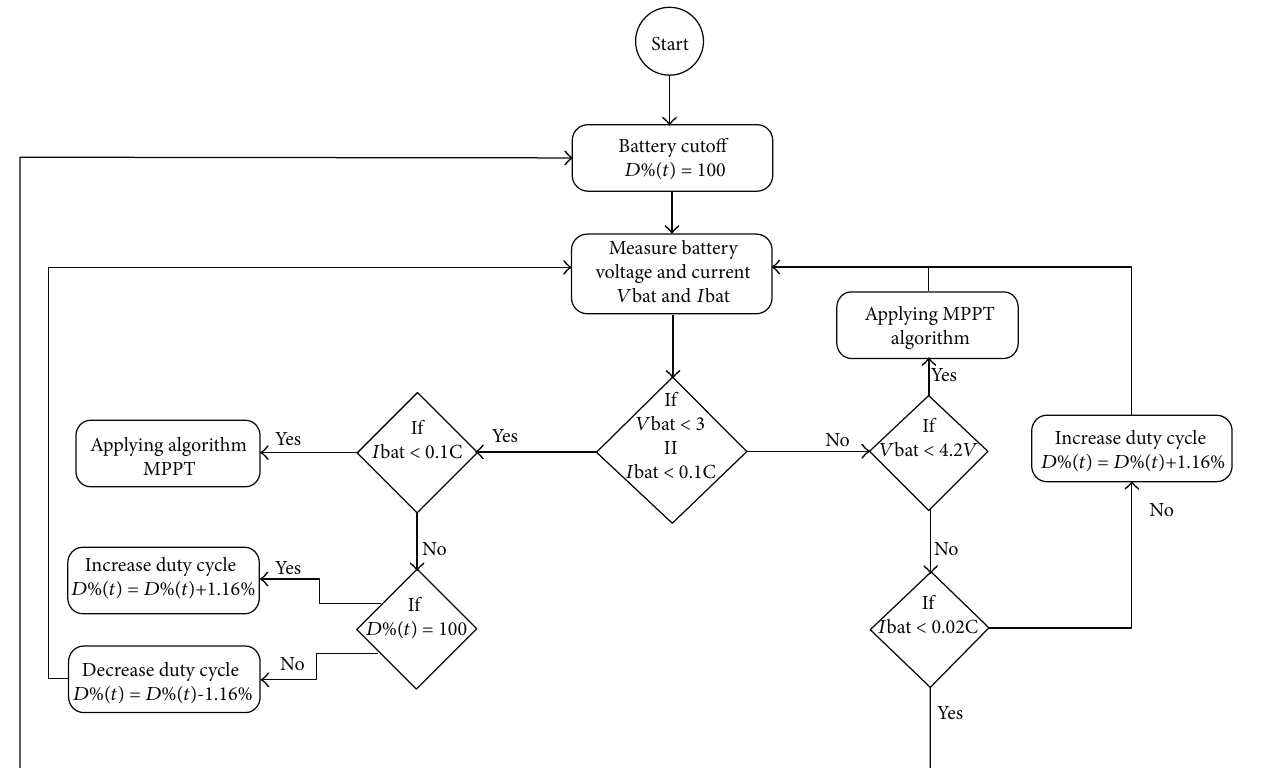
Figure 9: Flow chart of the designed charging control algorithm.